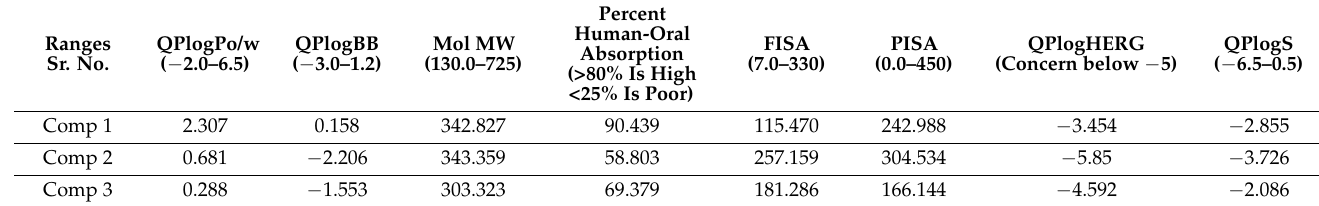
Table 2. ADME/T properties of all three compounds select after